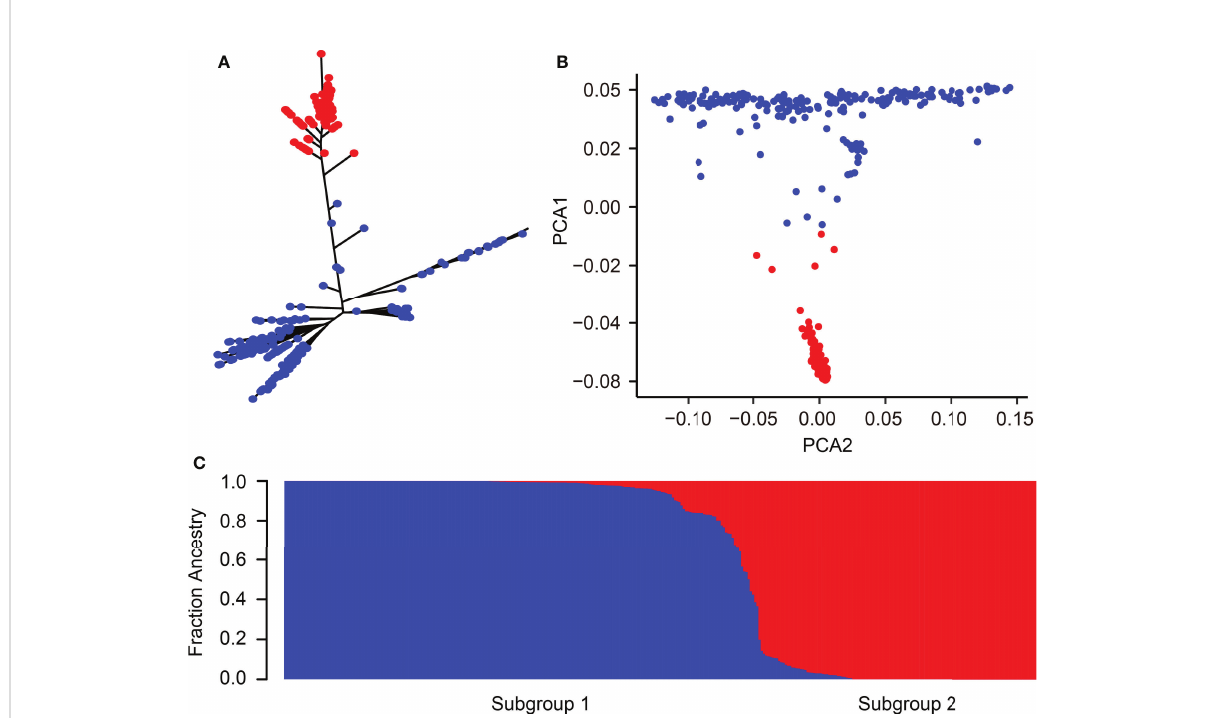
FIGURE 2 Population structure of 346 rice accessions. (A) Phylogenetic tree of 346 rice accessions. (B) PCA of 346 rice accessions. The fi rst and second principal components are represented by PCA1 and PCA2, respectively. (C) Cluster analysis of 346 rice accessions. Blue and red colors correspond to indica and japonica accessions,